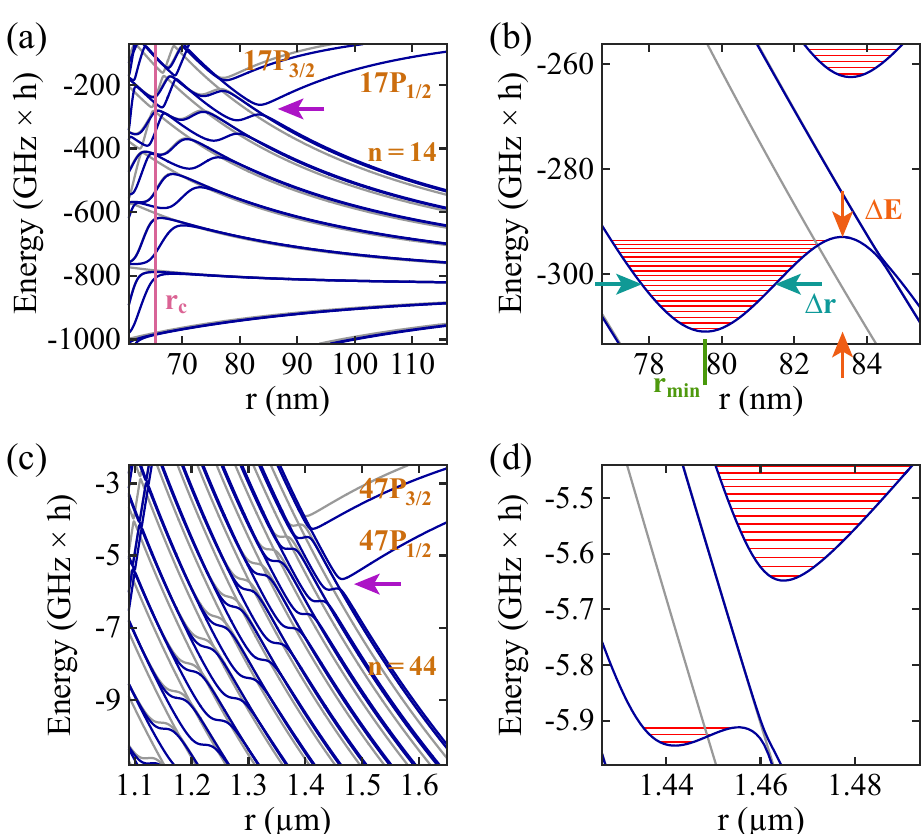
Figure 1. ( a ) Stark map level structure of a Rb atom in the vicinity of the 17 P state as a function of the internuclear distance r between the atom and the ion. The energy reference is given by the term energy of the 17 P 3/2 state at zero electric field corresponding to the value for r → ∞ . Blue (gray) solid lines represent levels with | m J | = 1/2 ( | m J | = 3/2), where m J is the magnetic quantum number. The purple vertical line marks a critical internuclear distance r c . For r (cid:46) r c , our model breaks down (see text). ( b ) Magnification of the region indicated by the magenta arrow in Figure 1a, showing the two outermost potential wells. The red solid horizontal lines correspond to vibrational level energies. The parameters ∆ E , ∆ r , and r min are used to characterize a potential well (see text). ( c , d ) Stark map and magnification of the vicinity of the 47 P state. Here, the energy reference is the term energy of the 47 P 3/2 state at zero electric